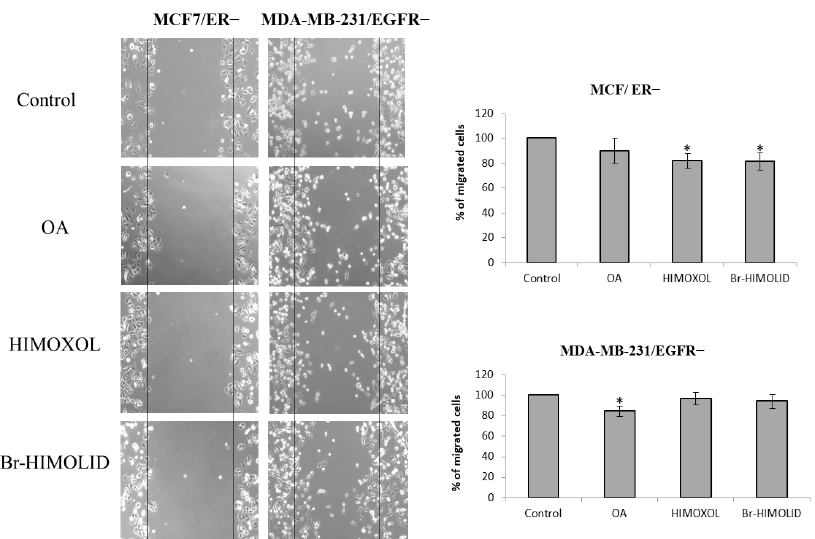
Figure 6. Effect of OA and its derivatives, HIMOXOL and Br-HIMOLID, on wound healing in MCF7/ER − and MDA-MB-231/EGFR − breast cancer cells. Cells were scraped with a pipette tip and treated with OA or OA derivatives (0.5 × IC 50 ) for 24 h. The photos represent cell migration under the microscope at 100 × magnification after scratch. The migration of studied breast cancer cells was quantified by measuring wound closure cells relative to control, untreated cells. The experiments were repeated two times. * p < 0.05 compared to the control cells.